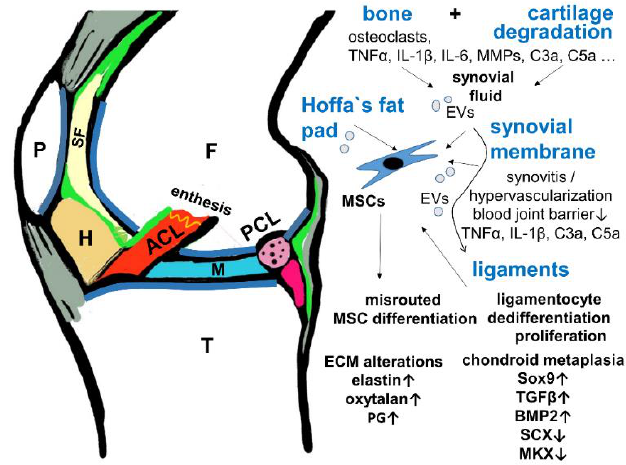
Figure 6. Hypothesis of the cross-talk between cartilage/bone and ligaments in OA. A scheme of a sagittal section of the knee is shown depicting the interrelation of the joint tissues involved in OA. ACL: red, F: femur, H: Hoffa ’ s fad pad, brown, M: meniscus, P: patella, PCL: transected, pink, SF: synovial fluid, pale yellow, T: tibia, green: synovial membrane, gray: patellar tendon, ligament and joint capsule. BMP2: Bone morphogenetic protein, EV: extracellular vesicles, PG: proteoglycans, MKX: Mohawk, SCX: scleraxis, TGFβ: transforming growth factor β.